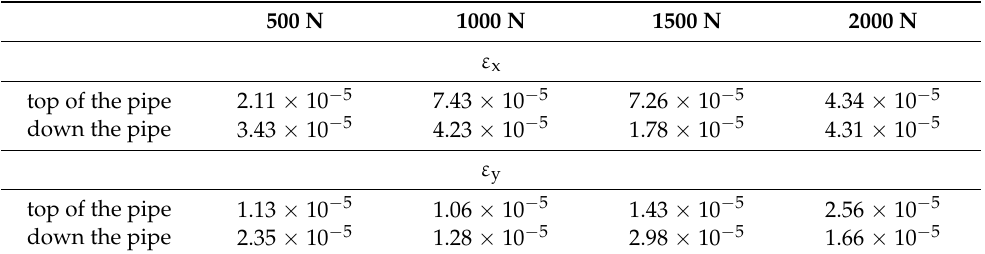
Table 1. Comparison of the differences in the values of longitudinal deformations ε x and transverse deformations ε y observed in the results of computer simulation and experimental tests.